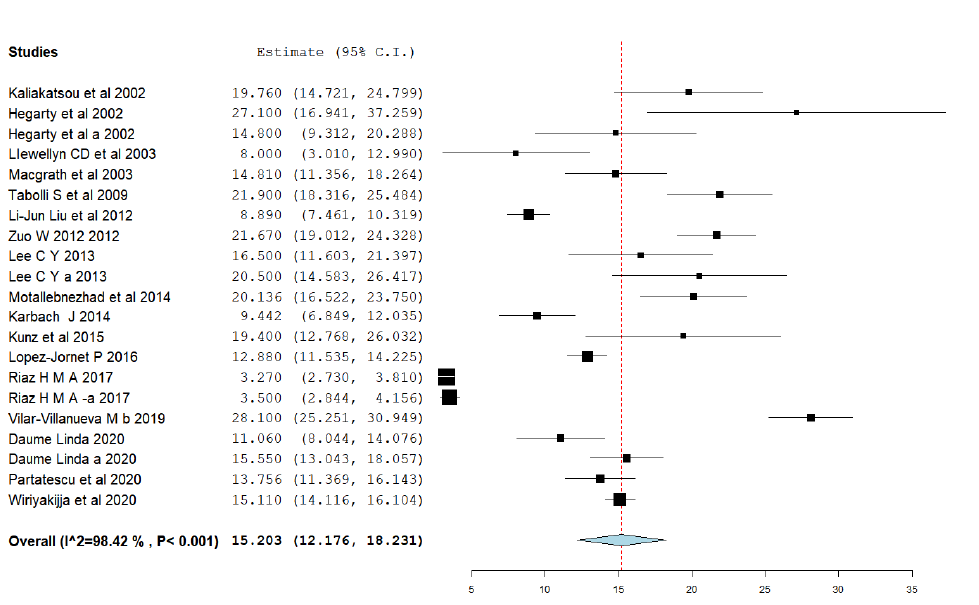
Figure 2. Baseline OHIP-14 score in OLP patients. Considering the high degree of heterogeneity, subgroup analysis based on age (>52 vs. <52 years), female proportion (>60% vs. <60%), and clinical type (keratotic/reticular vs erosive/ulcerative/bullous) was conducted (Figure 3a–c). The test for age subgroup differences suggested no statistically significant subgroup effect ( p = 0.21), meaning that Table 4. Oral Health-Quality of Life associated with oral lichen planus using the Short-Form Oral age does not modifies the impact of OLP on OH-QoL. Subgroup analysis for female proportion in samples showed a statistically significant subgroup effect ( p = 0.07), meaning Health Impact Profile (OHIP)-14 (Baseline). that gender statistically significantly modifies the impact of OLP on OH-QoL. The impact of OLP on OH-QoL appeared greater in studies with a larger number of females than males; therefore, the subgroup effect is quantitative. Few studies analyzed OH-QoL in the different clinical forms of OLP. Subgroup analysis based on clinical forms showed no statistically significant effect of clinical type of OLP on OH-QoL ( p = 0.84). There was no difference in OH-QoL between reticular, keratotic, erosive, bullous, atrophic types of OLP. Egger’s test for a regression intercept was significant ( p < 0.001), indicating evidence of publication bias (Figure